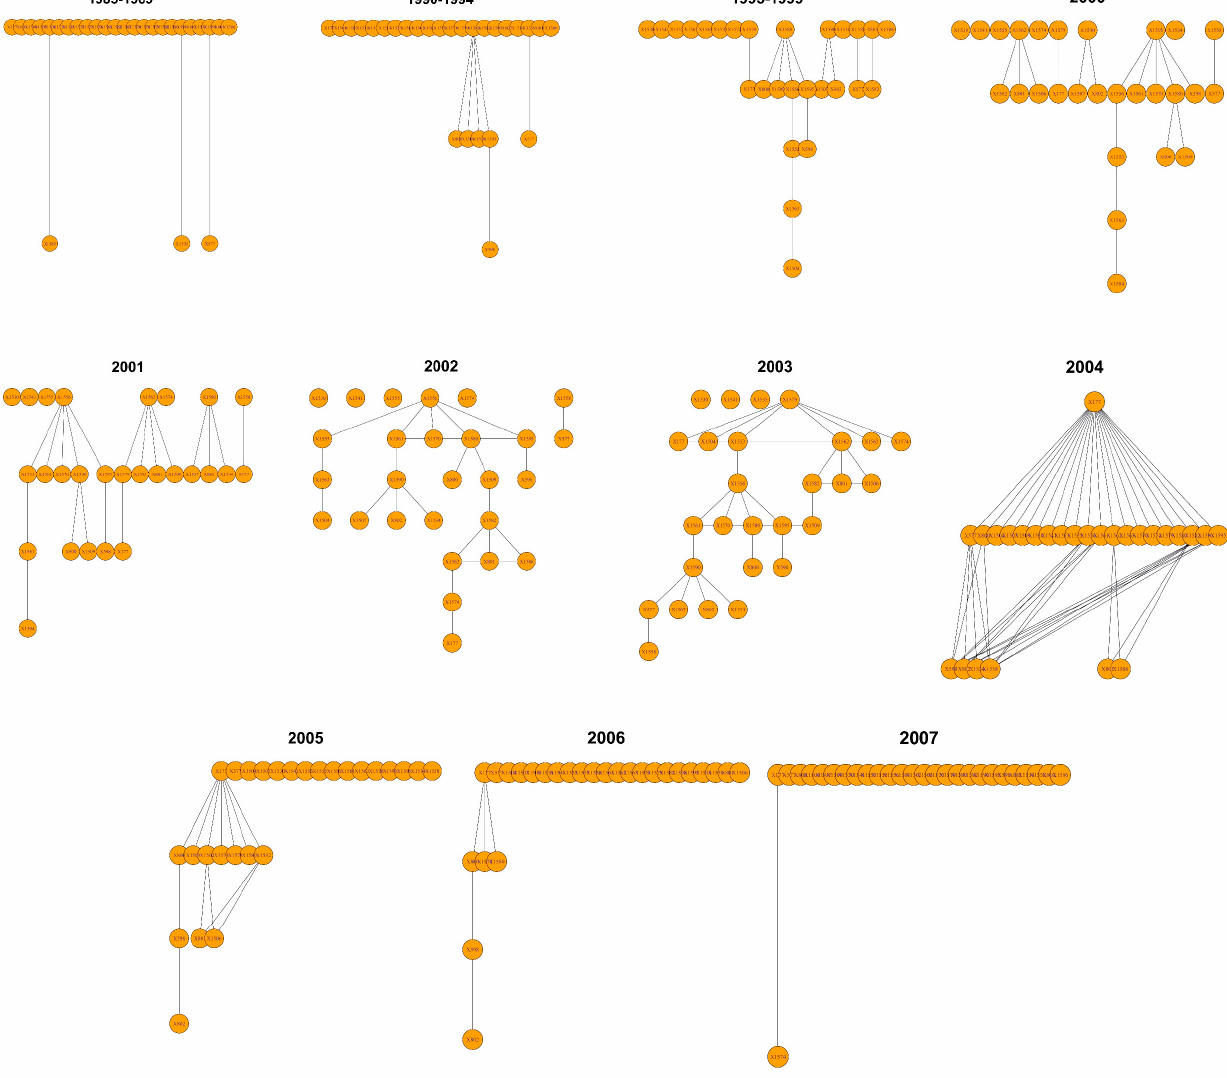
Figure 1. Temporal development of the Hirarchical structure of “Jamaah Islamiah section of Indo- nesia”. We observe a change of centralization in 2004.